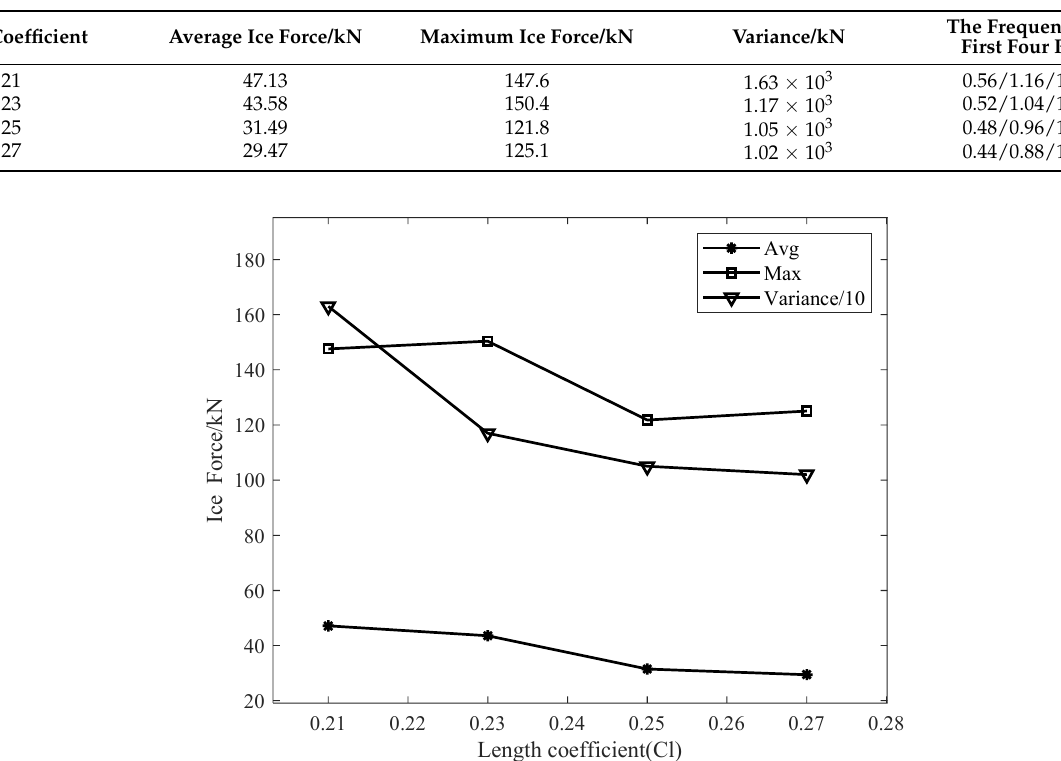
Figure 11. Frequency domain curves with different length coefficients ( C l ).